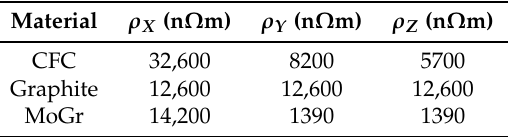
Table 3. Electrical resistivity of CFC, graphite and MoGr measured with the four-probe method on thick samples. X , Y , Z subscripts represent the 3 orthotropic directions of the materials (only graphite is